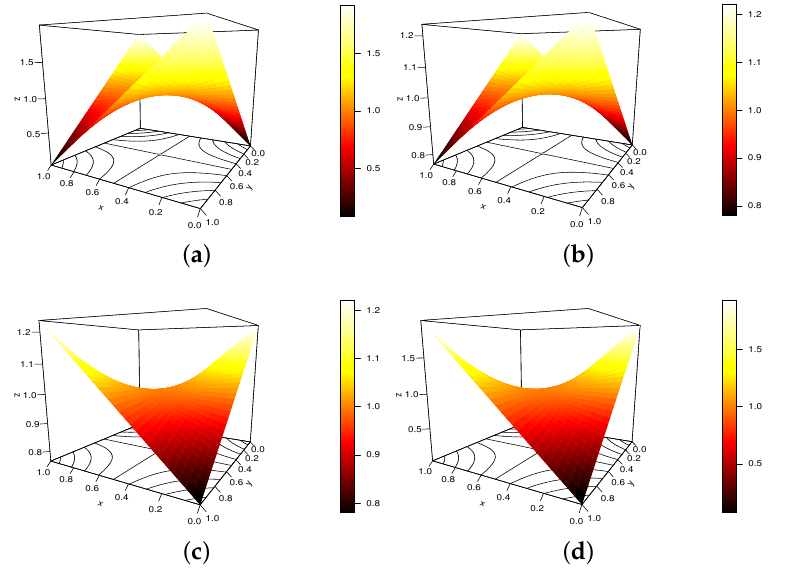
Figure 2. Display of the S copula density for β = π /2, γ = 1, and ( a ) α = − 0.63, ( b ) α = − 0.15, ( c ) α = 0.15 and ( d ) α =